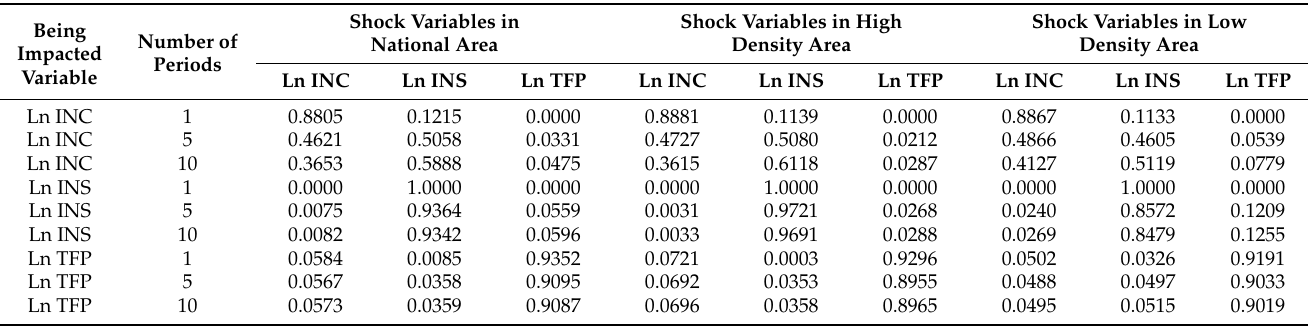
Table 6. Results of variance